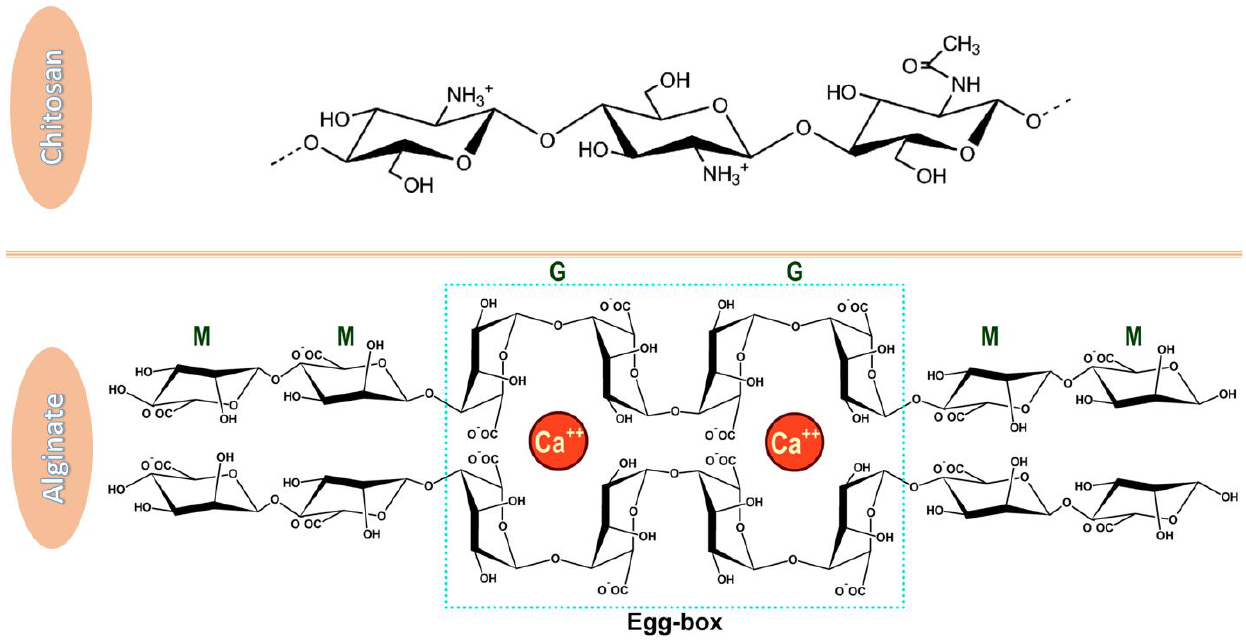
Figure 1. Chemical structures of chitosan and alginate. Chitosan has a linear structure comprised of β– (1-4) linked 2-acetamide-2-deoxy-d-glucose and 2-amino-2-deoxy-d-glucose [49], while alginate is a copolymer of β -D-mannuronic acid (M) and α -L-guluronic acid (G) which, in the presence of calcium ions form an egg-box structure [50]. Adapted from open-access sources.